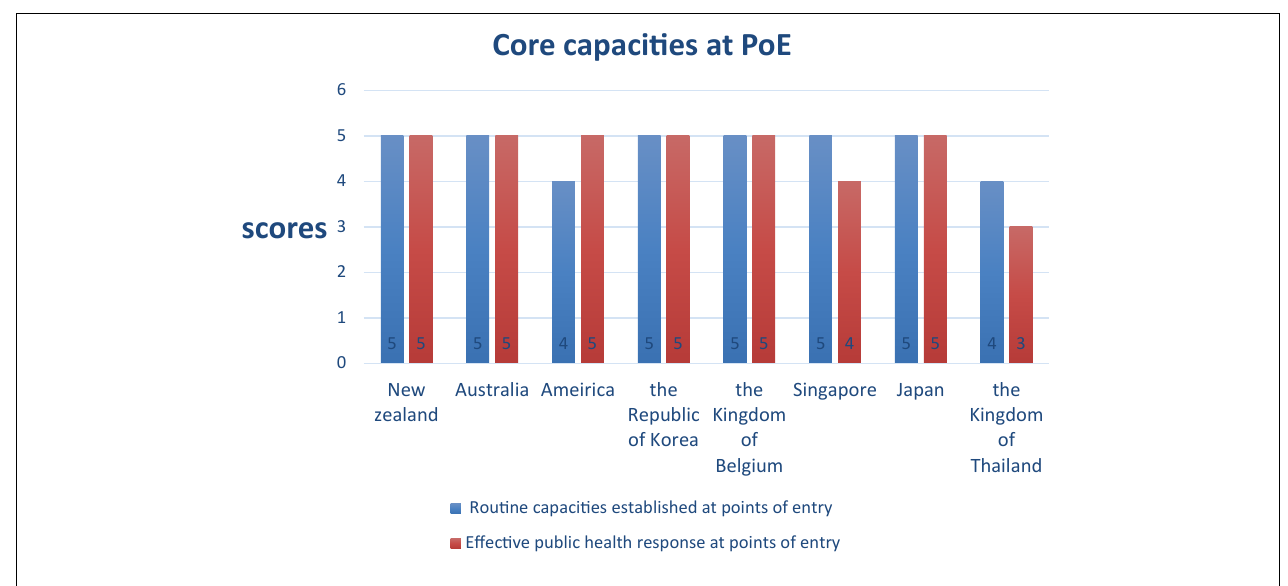
FIGURE 1 | Core capacities at the international